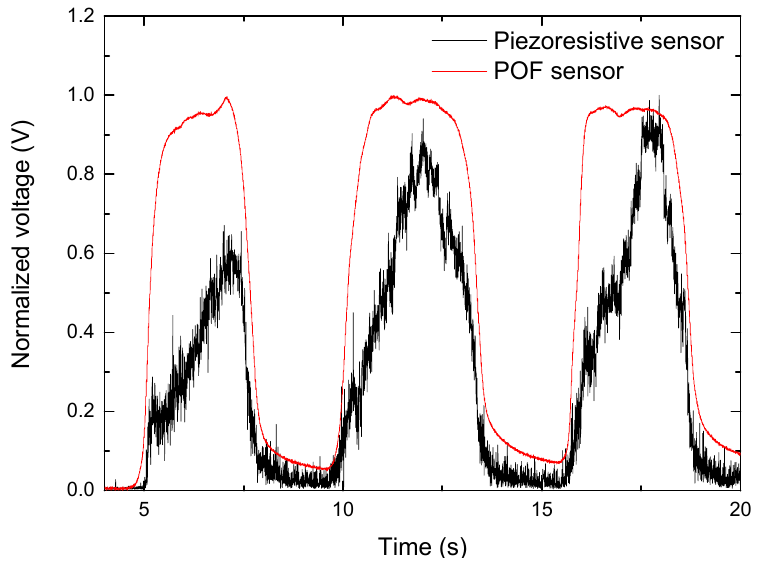
Figure 7. Simultaneous response of POF and piezoresistive sensors at the heel part of the insole.